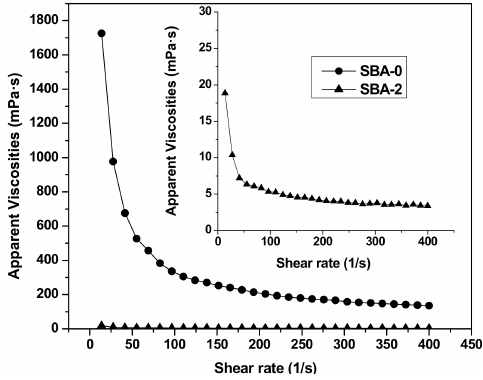
Figure 4. Rheological curves of SBA-0 and SBA-2.